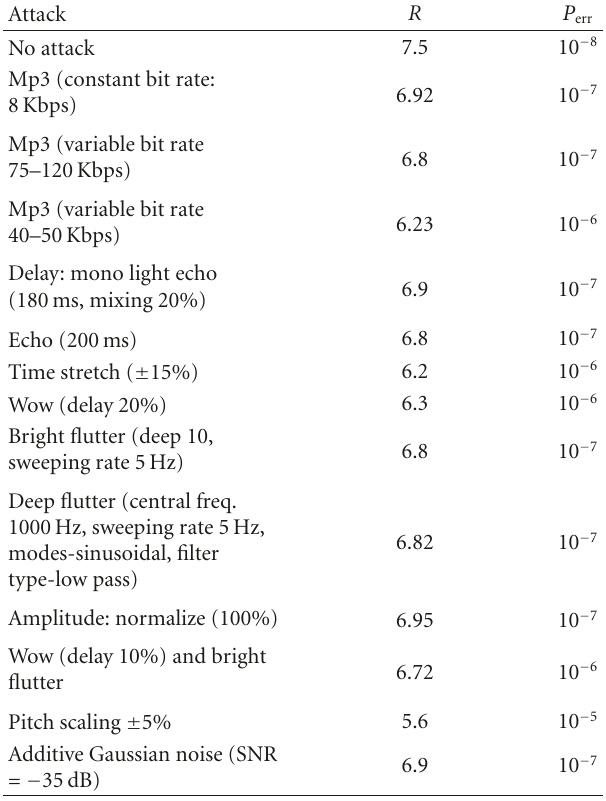
Table 1: Measures of detection quality and probabilities of error for di ff erent